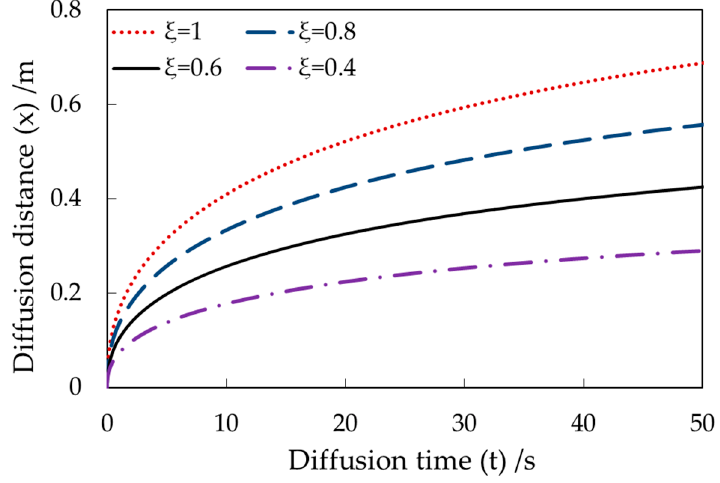
Figure 4. The change in the grouting diffusion distance with time under different roughness factors.